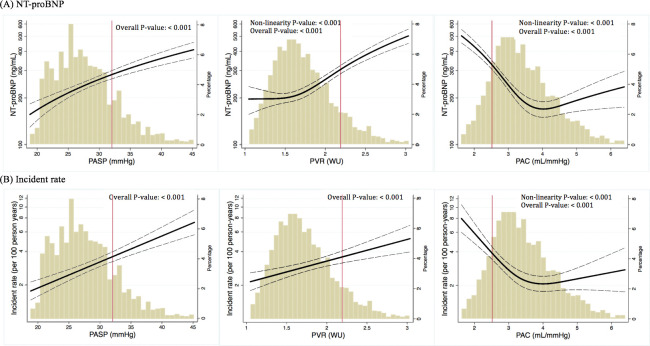
Association of pulmonary hemodynamic measures with (A) plasma NT-proBNP concentrations and (B) incident HF or death post visit 5. Histogram shows the distribution of the primary hemodynamic variable in the study sample. Black dotted line represents 95% confidence interval. Red line indicates the ARIC-based reference value for abnormal for that pulmonary vasculature measure (see text for details). p-Values are derived from cubic spline model adjusted for age, sex, race, visit center, and LV measures (LVEF, LAVi, LVMi, and septal E/E’). ARIC, Atherosclerosis Risk in Communities; HF, heart failure; LAVi, left atrial volume index; LV, left ventricular; LVEF, LV ejection fraction; LVMi, LV mass index; NT-proBNP, N-terminal prohormone brain natriuretic peptide; PAC, pulmonary arterial compliance; PASP, pulmonary artery systolic pressure; PVR, pulmonary vascular resistance; WU, Wood unit.